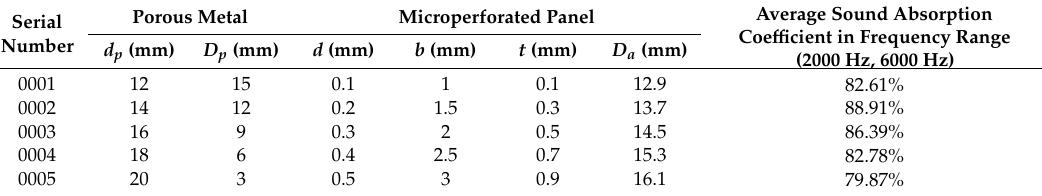
Figure 2. Qualitative comparisons of sound absorption coefficient of the composite sound absorbing structures with the varied structural parameters. Table 1. The selected parameters for studying their influence on the sound absorption performance.